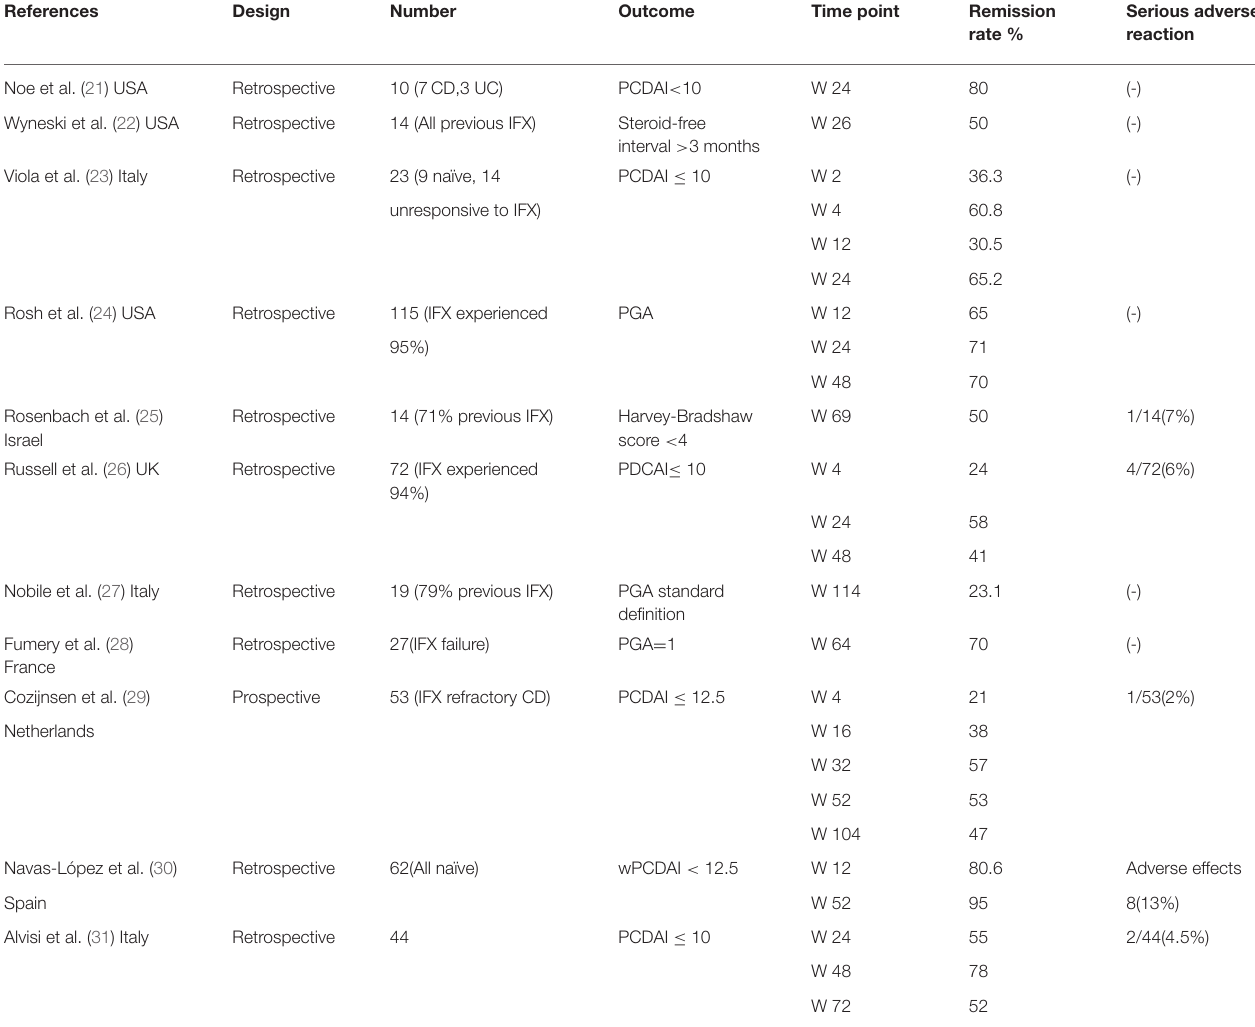
TABLE 1 | Efficacy for clinical remission of